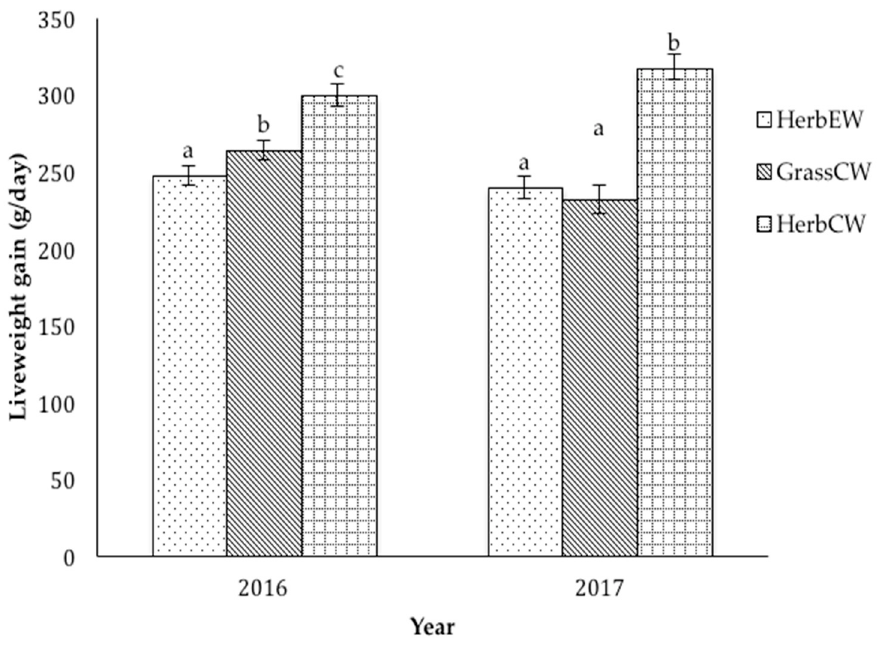
Figure 2. Liveweight gain (g/day) of lambs, from early weaning to conventional weaning, in the Herb EW , Herb CW and Grass CW treatments in 2016 and in 2017 ( a–c means with different superscripts are significantly different within each year and treatments).